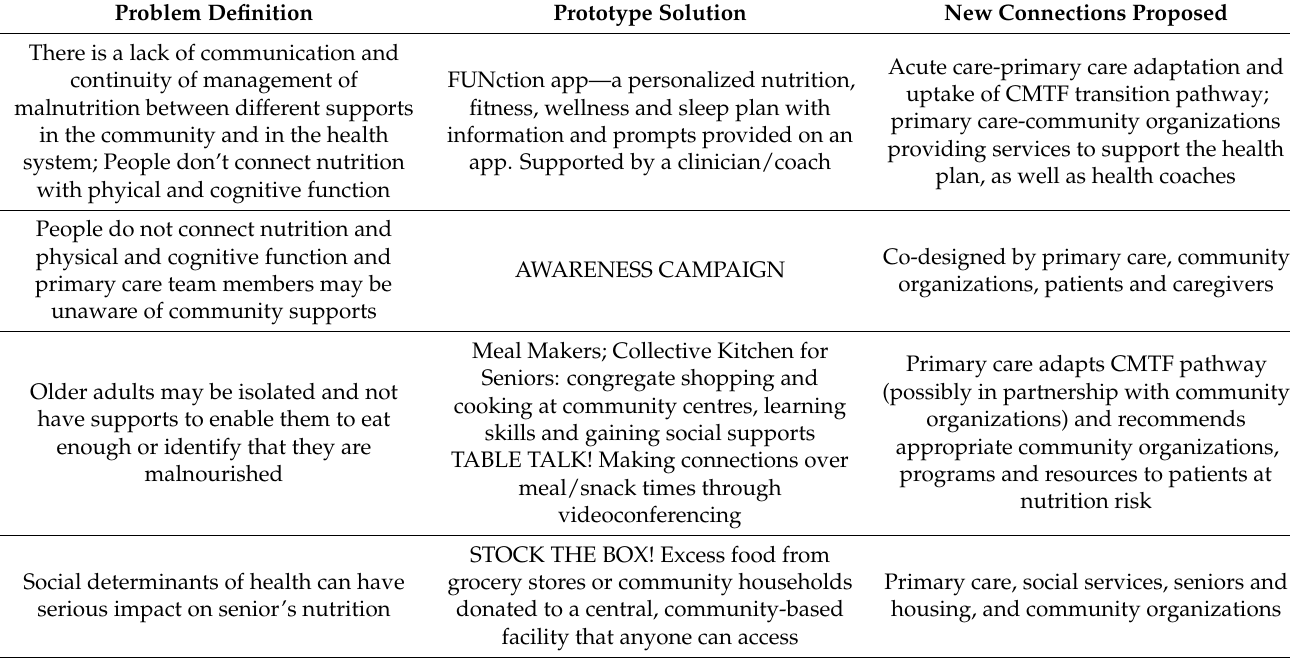
Table 4. Problem Statements, Adapted from Problem Statements Generated at the Symposium (Phase 2), Ideas for Solutions Developed During the Workshop (Phase 3), and the Intersectoral Connections Required to Enable the